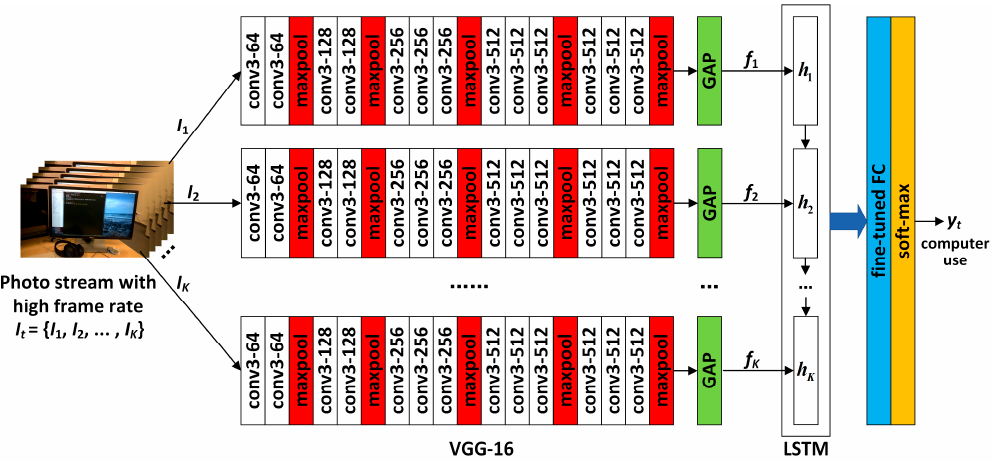
Figure 7. Architecture of the proposed CNN-LSTM network for high-frame-rate photo streams.